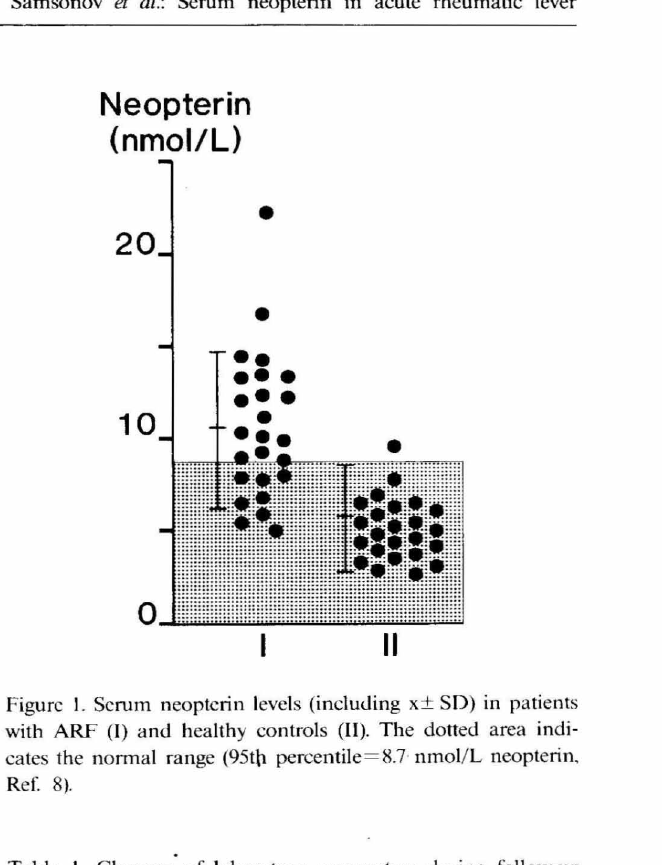
Figure I. Serum neoptcrin levels (inclul1ing x± SD) in patients with ARF (I) and healthy controls (II). The dottel1 area indi cates the normal range (95t\1 percentile=8.7 nmol/L neopterin. Re[